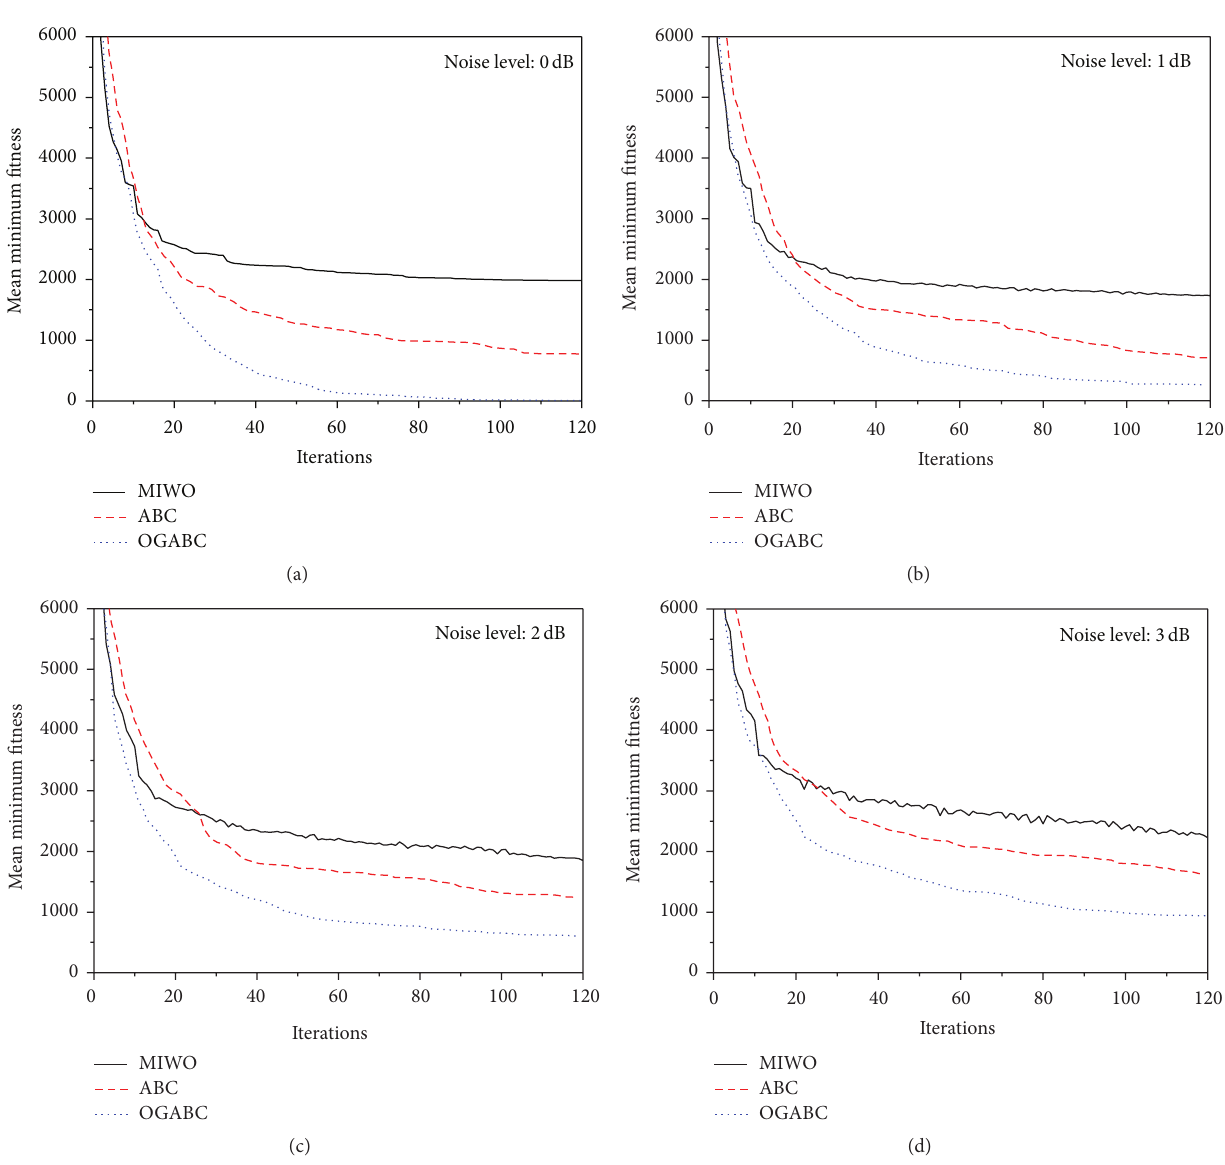
Figure 6: The comparison of the convergence curves of different algorithms with the same noise